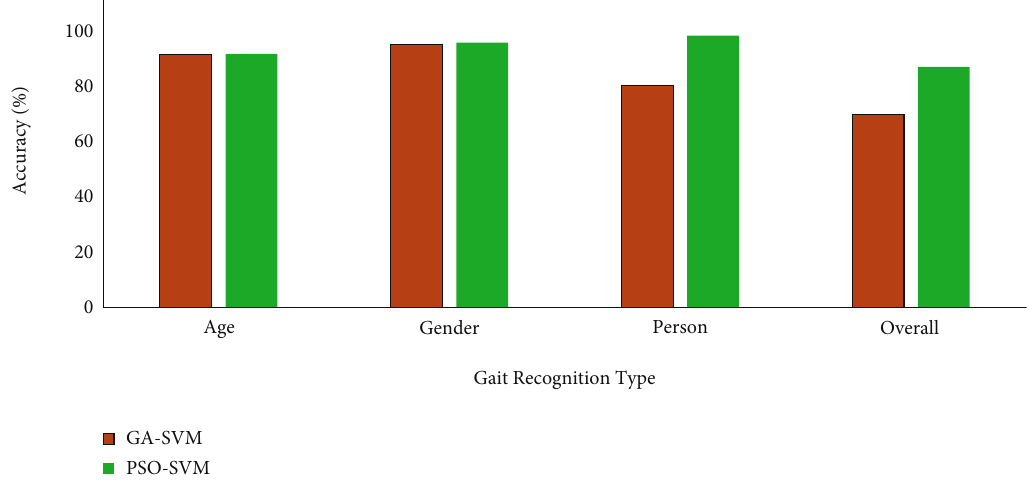
Figure 12: Accuracy using SVM classi fi er.